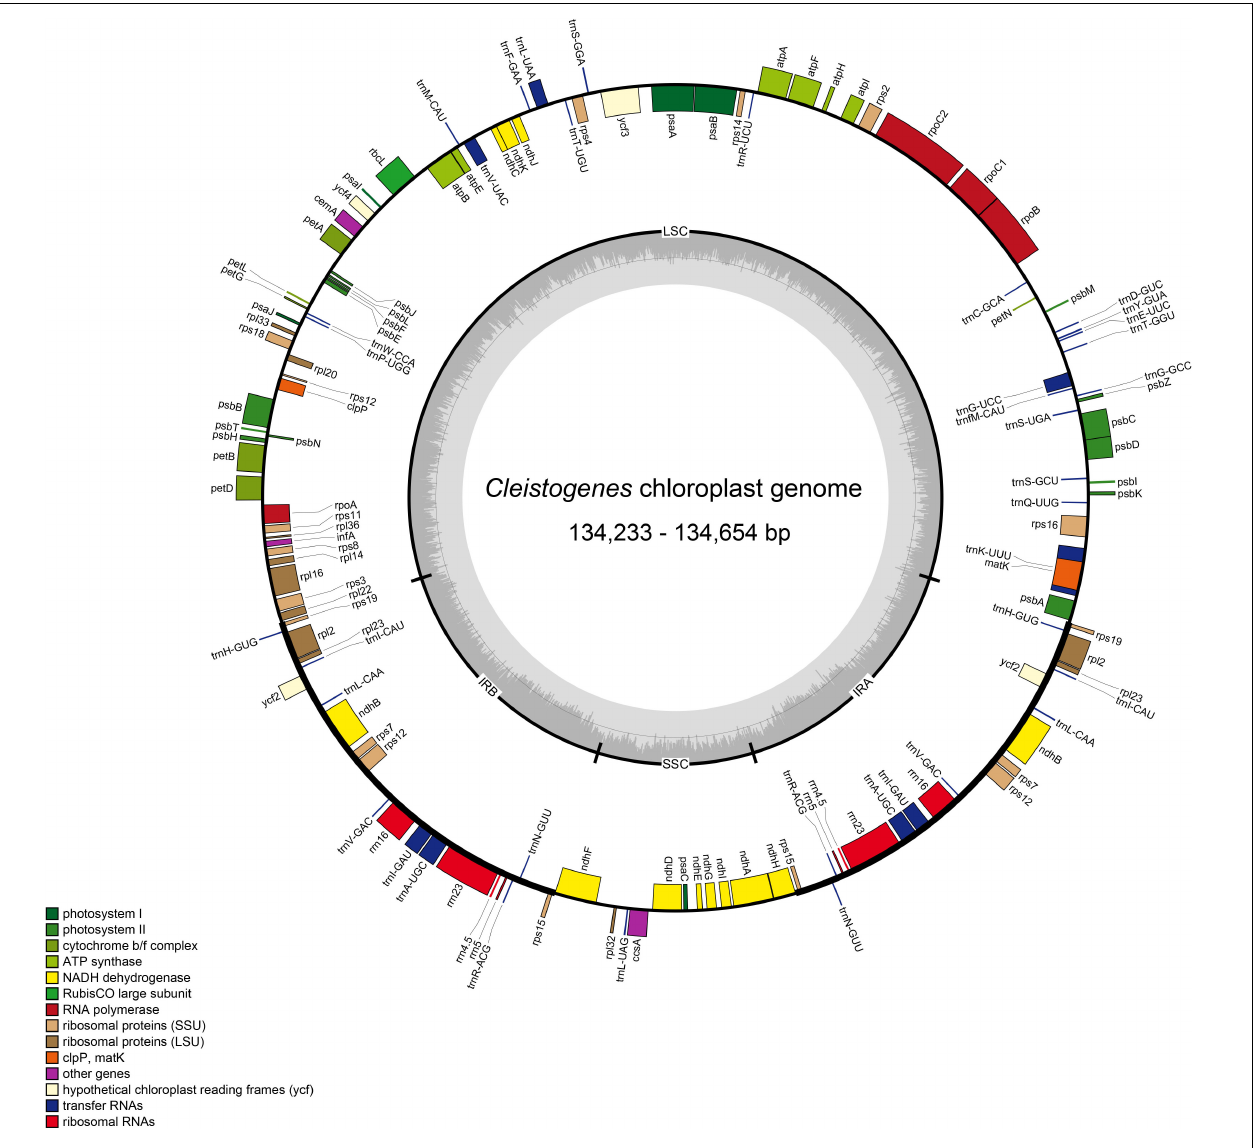
FIGURE 1 | Plastome map of twelve Cleistogenes taxa. Genes on the inside of the map are transcribed in the clockwise direction, while genes on the outside of the map are transcribed in the counterclockwise direction. The dashed darker gray area in the inner circle indicates the GC content, while the lighter gray area shows the AT content. IR, inverted repeat; SSC, small single-copy; LSC, large